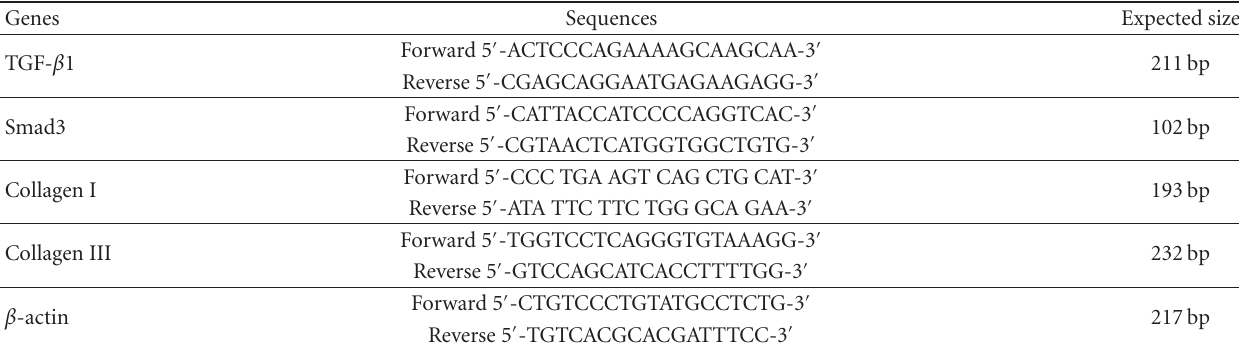
Table 1: Primers for real-time